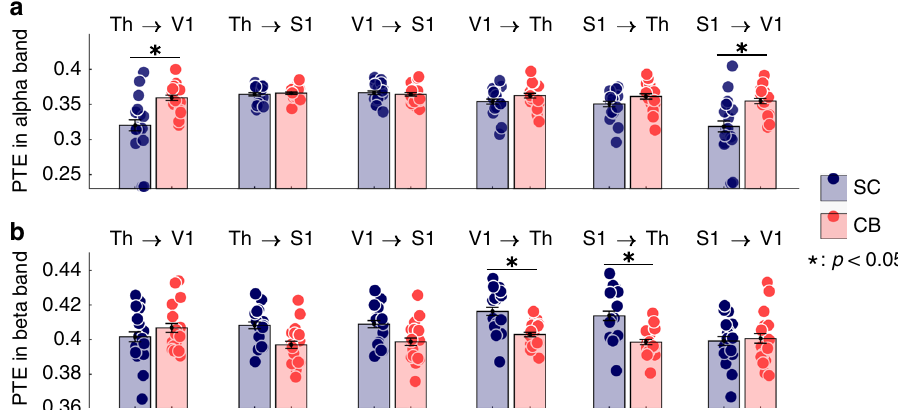
Fig. 3 Directed functional connectivity measured with phase-transfer entropy (PTE). a CB subjects showed stronger directed connectivity in the alpha frequency band (8 – 12 Hz) from thalamus (Th) to V1 ( p = 0.019) and from S1 to V1 ( p = 0.05; two-tailed Wilcoxon rank-sum test, Bonferroni corrected). b SC subjects showed stronger PTE connectivity in the beta-band (12 – 30 Hz) directed from S1 ( p = 0.027) and V1 ( p = 0.021) to thalamus